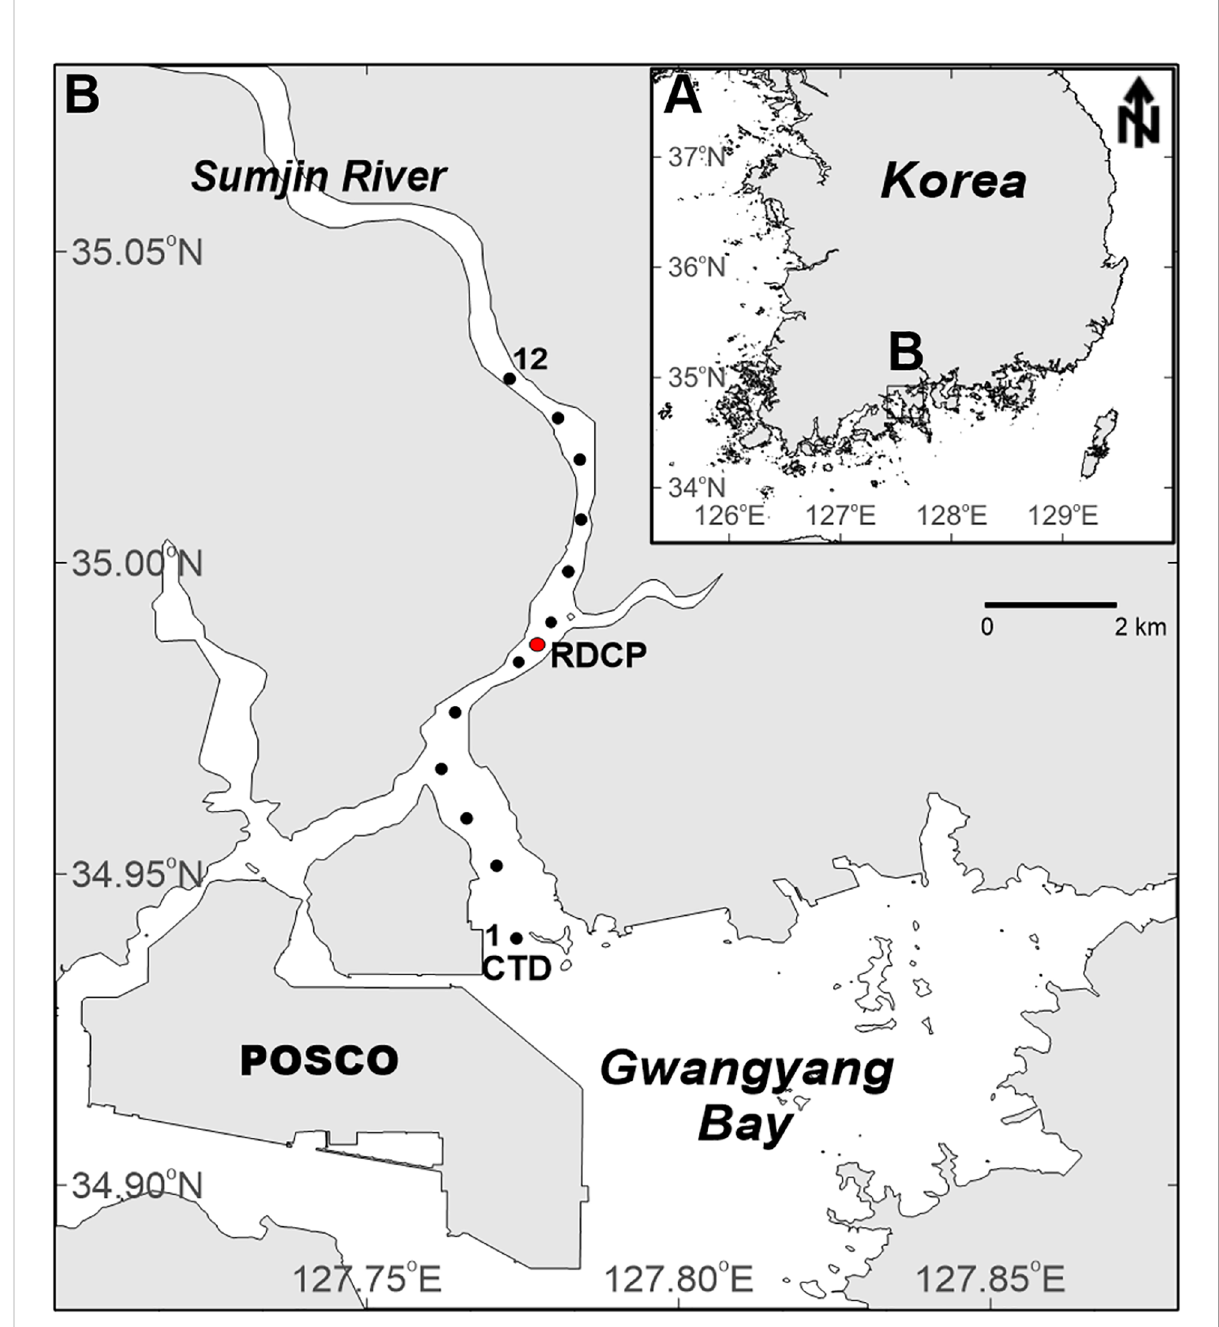
FIGURE 1 Study area and observation stations: (A) Overview map of Korea; (B) the Sumjin River estuary, including the Conductivity – Temperature – Depth (CTD) stations 1 – 12 (black circles), the current mooring station (red circle), and the Gwangyang tidal gauge